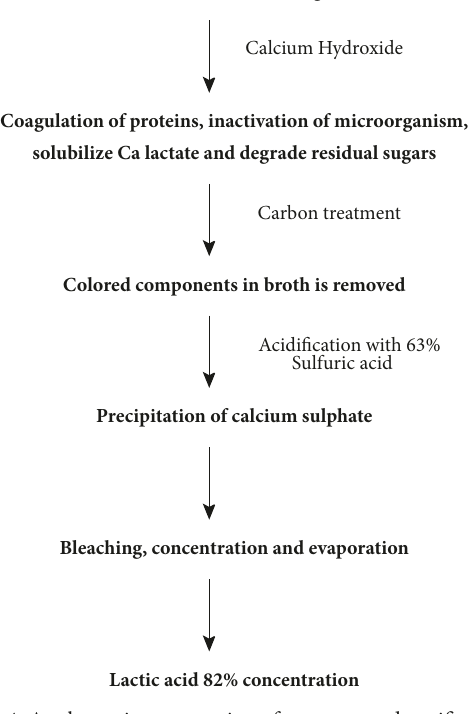
Figure 4: A schematic presentation of recovery and purification of lactic acid from fermentation of broth by